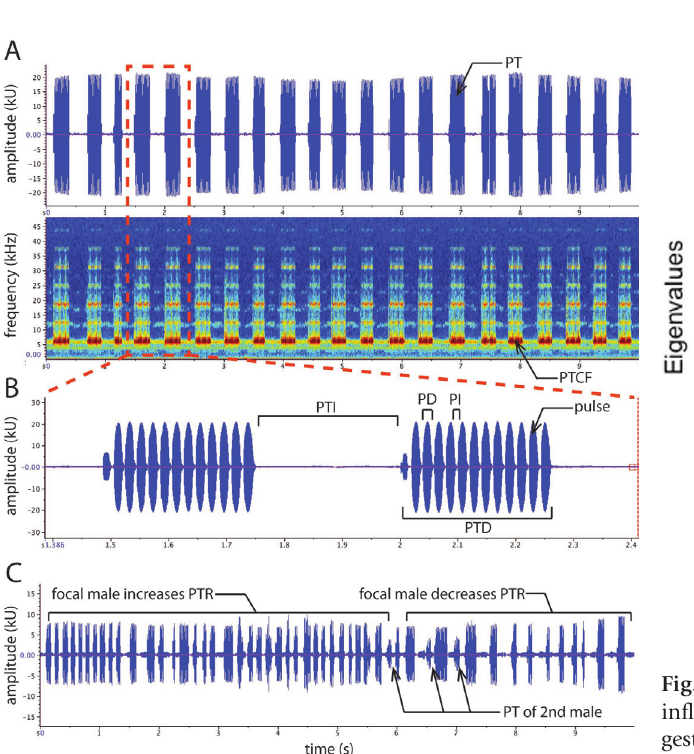
Fig. 3. A. Male calling song, field recording number 140723_11, os- cillogram (above) and spectrogram (below), 10 s window, 25.4°C. PTR = 2.2 s -1 , PTCF = 6.3 kHz; B. 1 s window of same recording as in A, expanded from region surrounded by red box, showing pulse structure; C. 10 s oscillogram of interaction between two males in the field, recording 140723_09, 23.9°C. Changes in PTR of focal male are